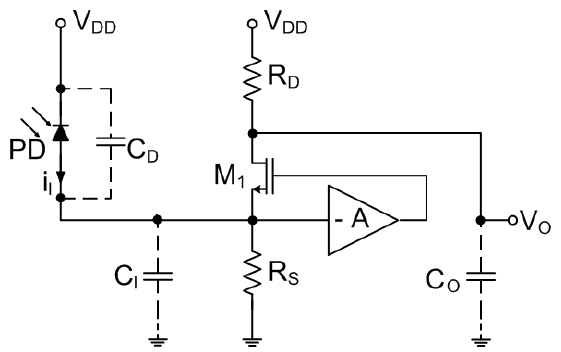
Figure 6. Regulated cascode